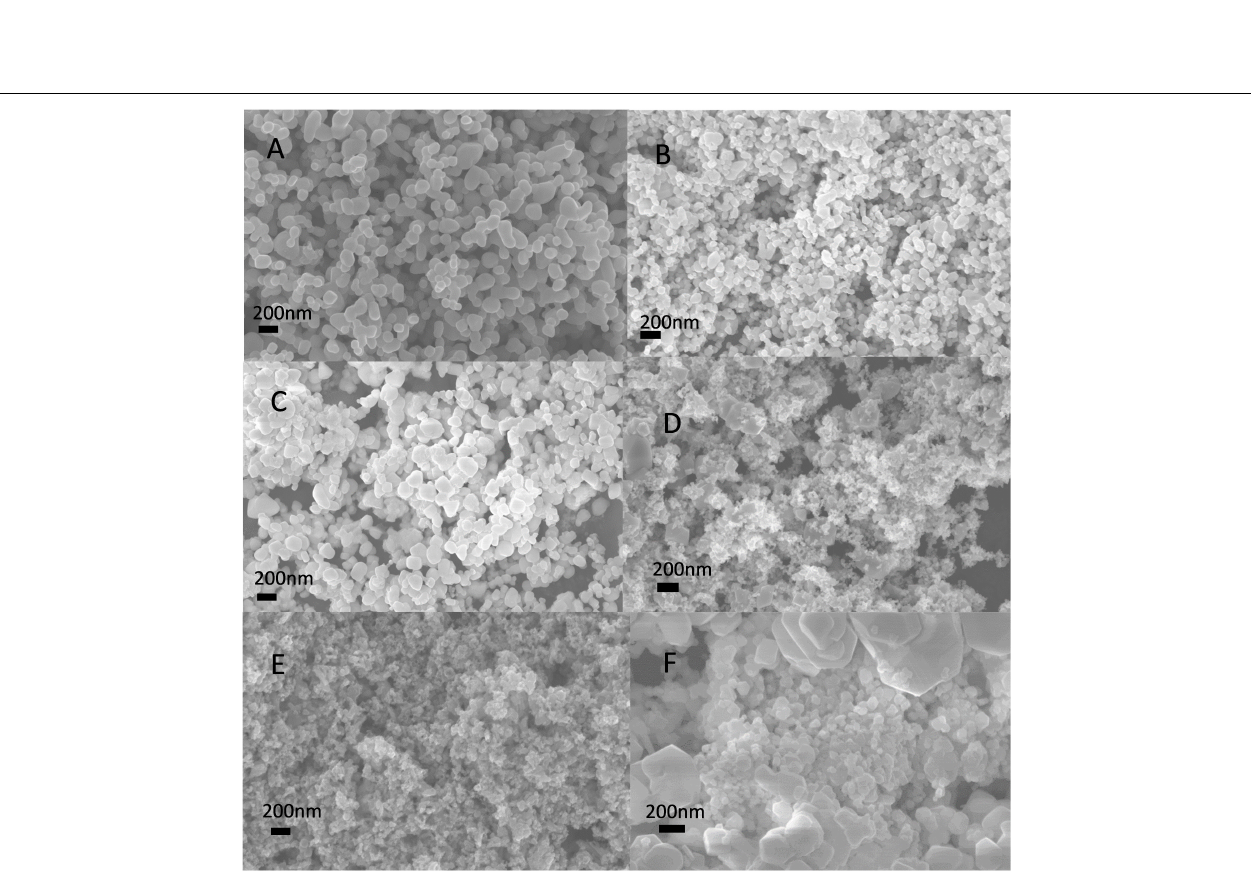
Frontiers in Materials |